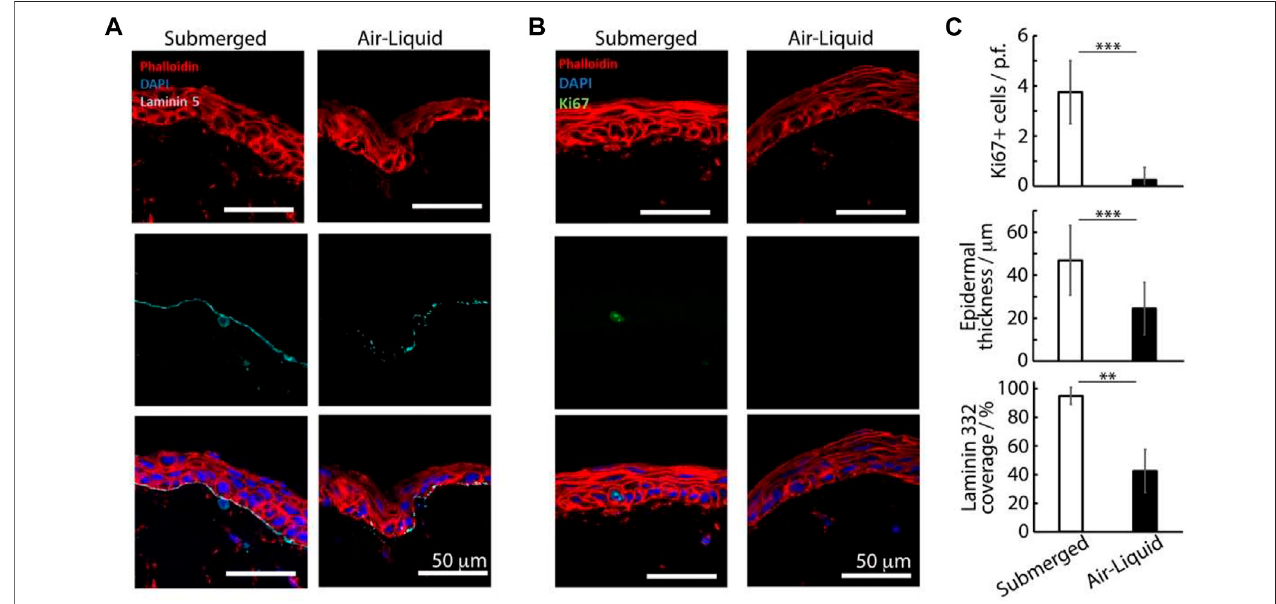
FIGURE3| Histologysectionsofavascularskin-on-chip constructsimmuno-stained withphalloidin(red), DAPI(blue),andforlaminin332, (A) cyanorKi67and (B) green. After an initial culture of 7 days, tissues were further cultured for 7 days in submerged or air-liquid conditions. (C) Quanti fi cation of the corresponding density of Ki67+ cells, epidermal thickness and coverage of laminin 332. ** p < 0.01; *** p < 0.001; n.s., non-signi fi cant, p > 0.05; error bars are standard errors; n = 3.